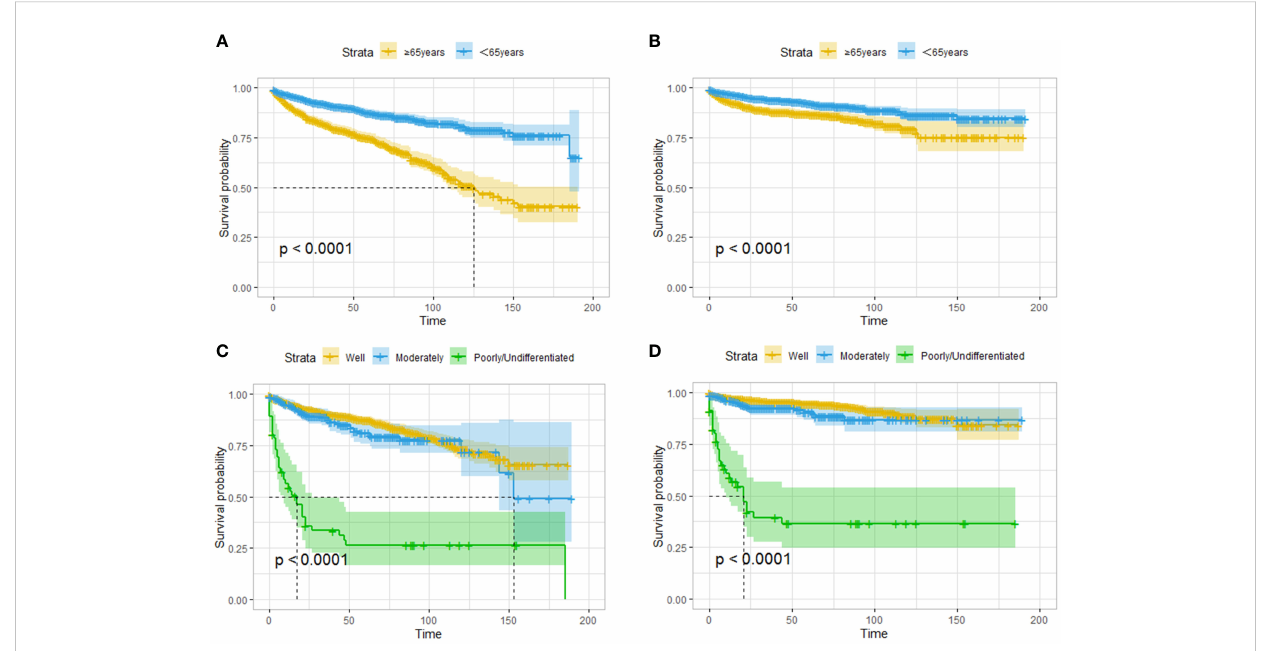
FIGURE 3 Survival analysis based on age: OS (A) and CSS (B) of all the patients. Survival analysis based on the degree of tumor differentiation: OS (C) and CSS (D) of all the patients. Elderly patients have lower OS and CSS, and the degree of tumor differentiation affects the prognosis.